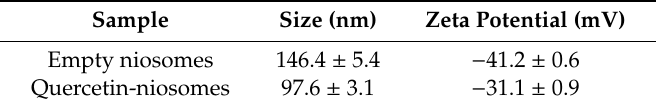
Table 3. Size and zeta potential of empty niosomes and quercetin-niosomes. Figure 4. ( a ) Appearance of empty niosomes and quercetin-niosomes; ( b ) Transmission electron microscopy (TEM) image of blank niosomes; ( c ) TEM image of quercetin-niosomes.